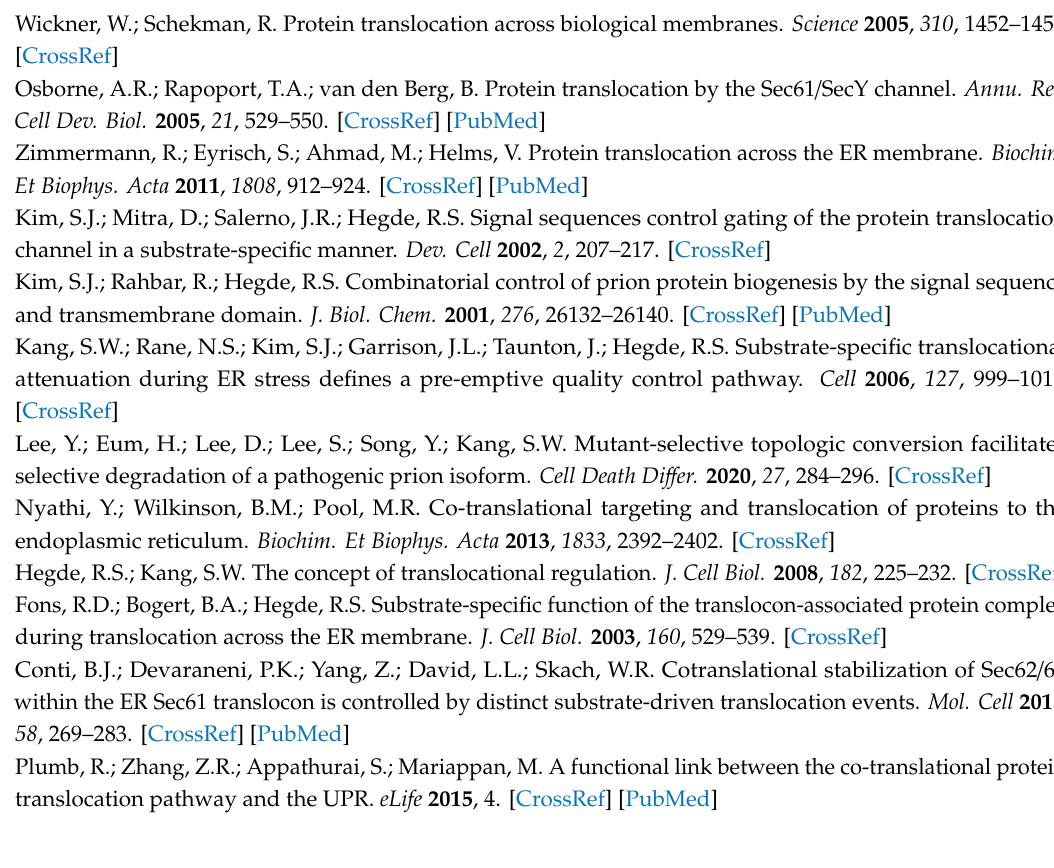
Figure S1: Identification of p90 by LC-MS / MS; Figure S2: E ff ect of PATC on the typical outcomes of ER stress; Figure S3: E ff ect of PATC on PrP metabolism and processing; Figure S4: E ff ect of PATC on the expression of the core translocon components and major ER chaperones; Figure S5: E ff ect of PATC on ctmPrP turnover; Figure S6: E ff ect of PATC on DTT-induced translational